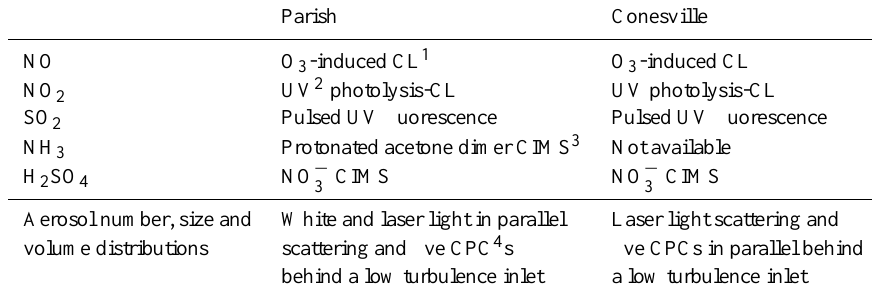
Table 1. Measurements and instrumentation for each investigated power